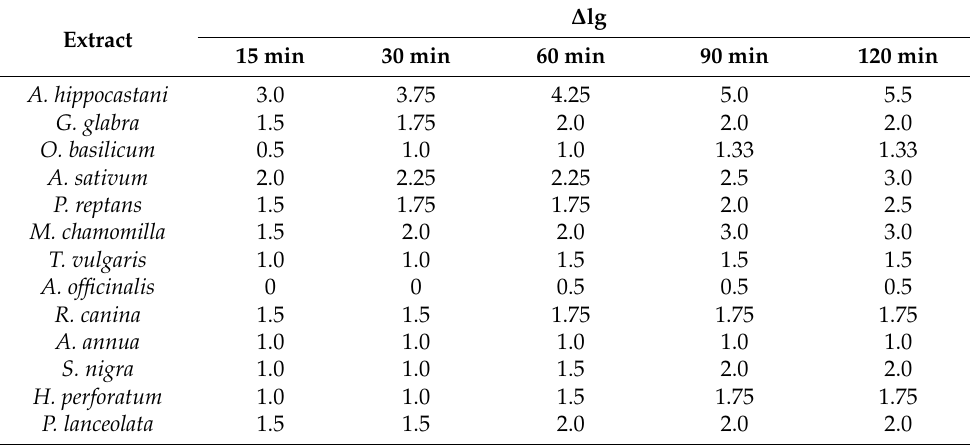
Table 9. Protective effect of pre-treatment of extracts on healthy MDBK cells and subsequent HSV-1